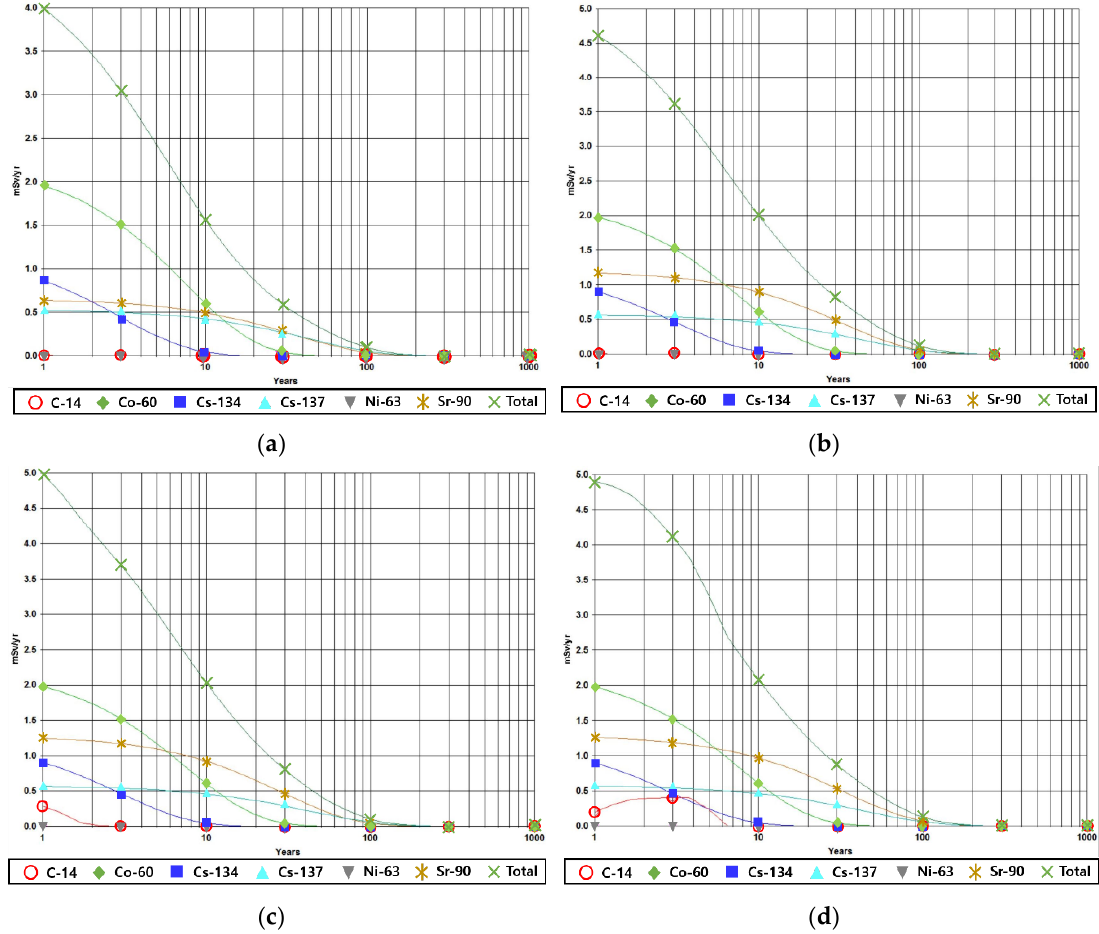
Figure 3. Dose graph by time according to value: ( a ) upper value, ( b ) median value, ( c ) lower value, and ( d ) default value.